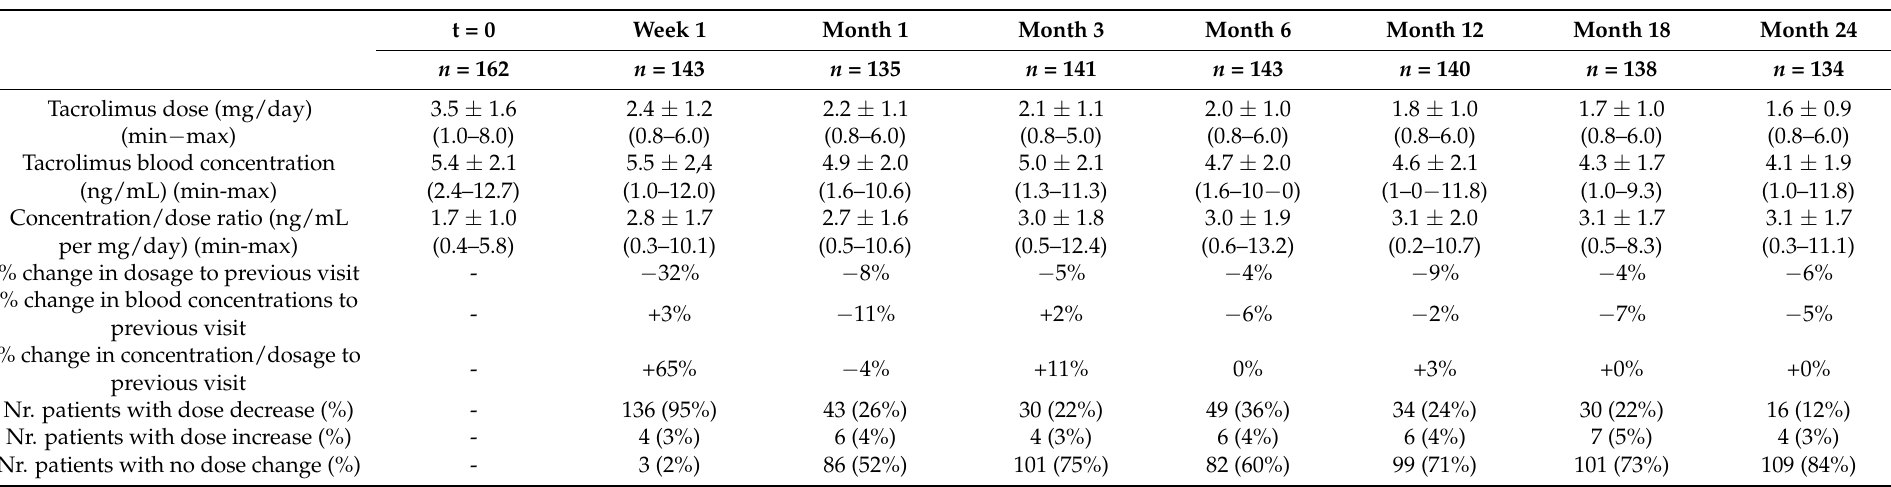
Table 4. Tacrolimus pharmacokinetic parameters at baseline and after conversion to LCP-Tac, mean ± SD, min-max or n (%). Includes all available